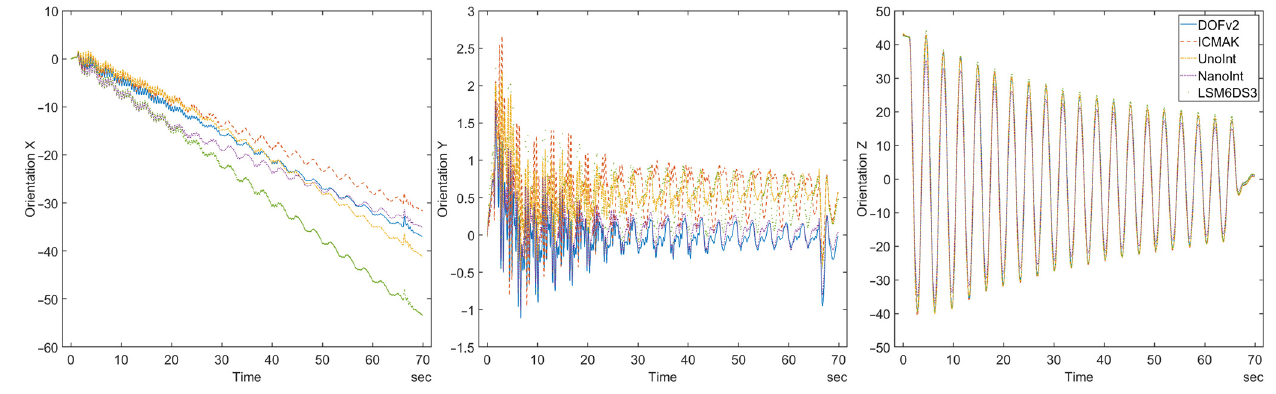
Figure 16. The orientation of the DIY sensors calculated in all three axes.